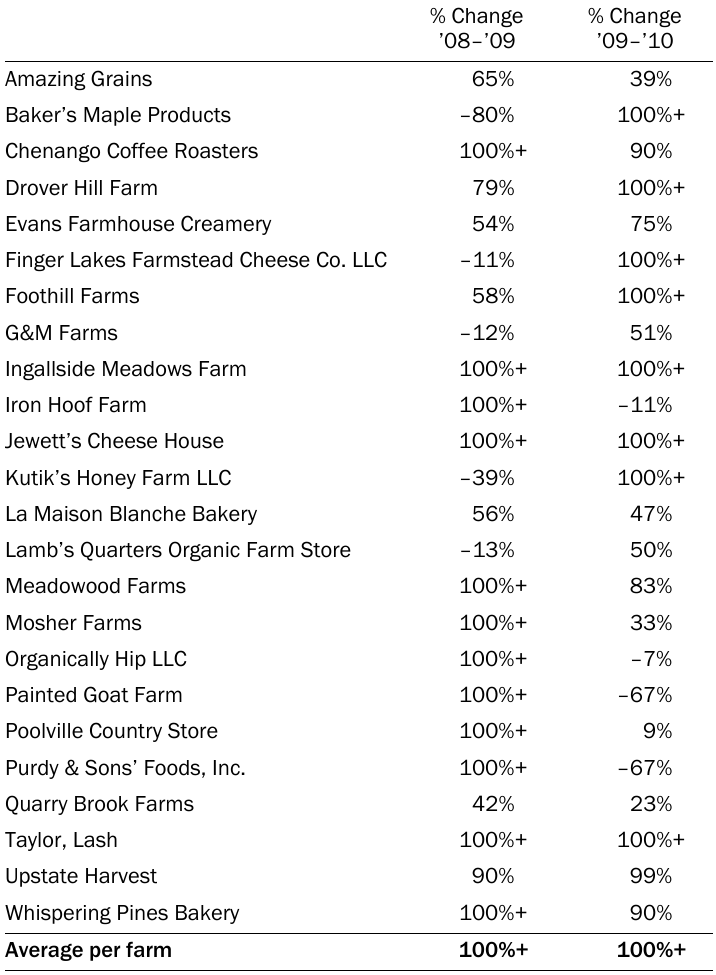
Table 4. CNY Bounty Farms That Have Been Consistently